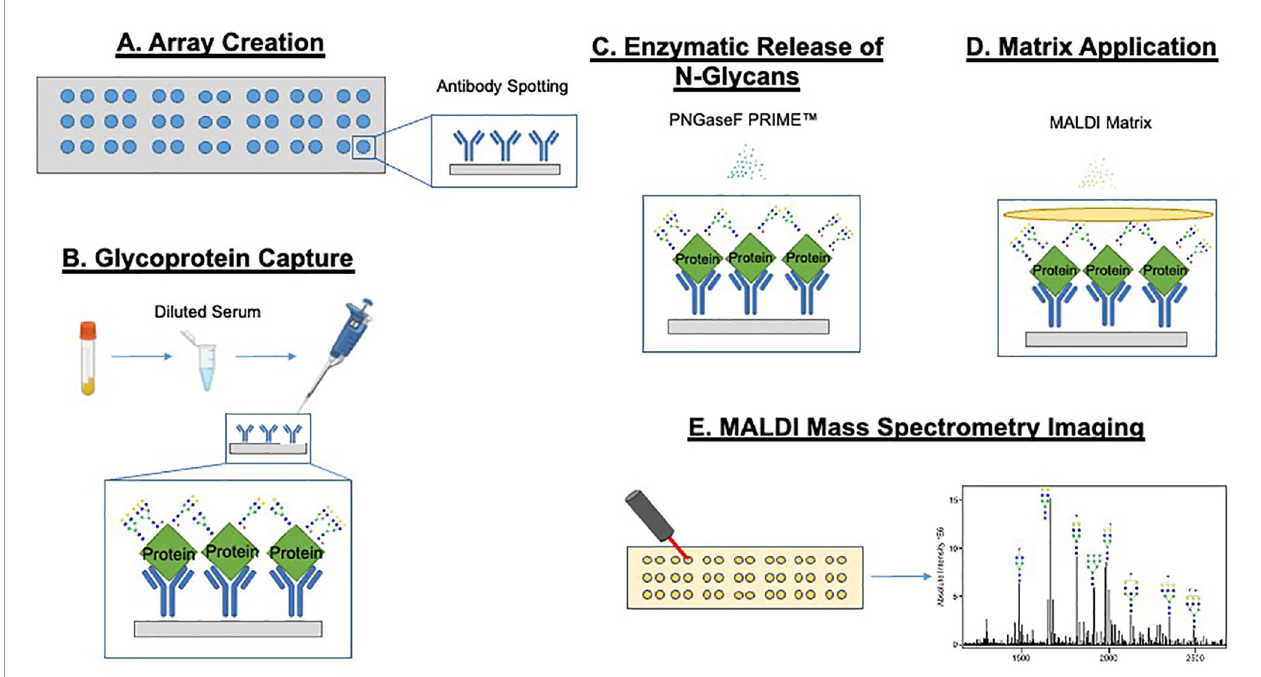
FIGURE 1 | GlycoTyper work fl ow for the glycan analysis of antibody captured glycoproteins. The fi rst step is the creation of the antibody array using the desired antibodies immobilized on nitrocellulose coated slides (A) . Subsequently, the antibody array is incubated with either diluted serum or any other protein mixture (B) . Slides are washed after protein capture using a mass spectrometry compatible detergent before glycan are released by application of a thin coating of recombinant PNGase F to the slide (C) . MALDI matrix is applied to the tissue and the slide imaged using a MALDI-Mass spectrometer (D, E)